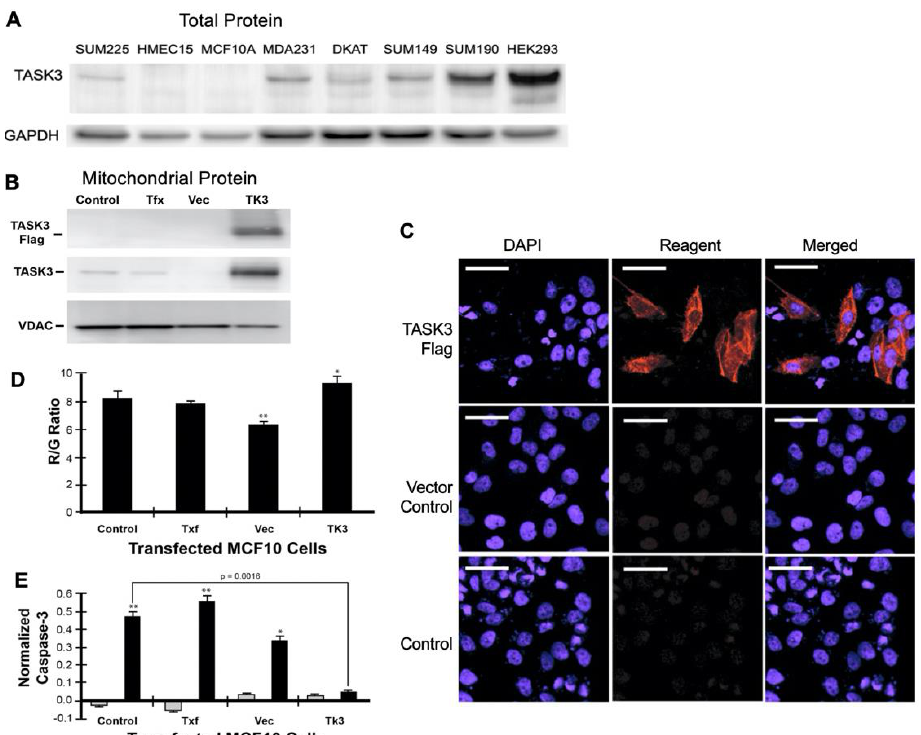
Figure 5. TASK3 expression and localization in breast cancer cell lines and mammary epithelial cell lines and cell strains. ( A ) Endogenous total TASK3 protein expression in human breast cell